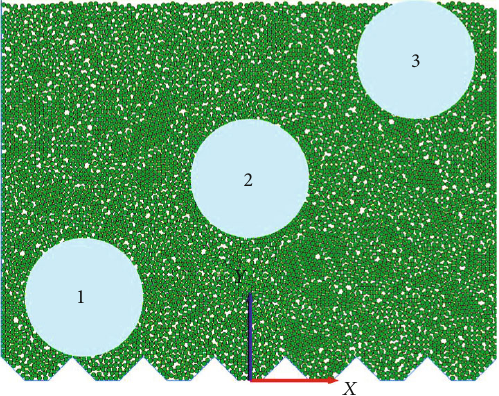
Figure 8: Arrangement of the measuring